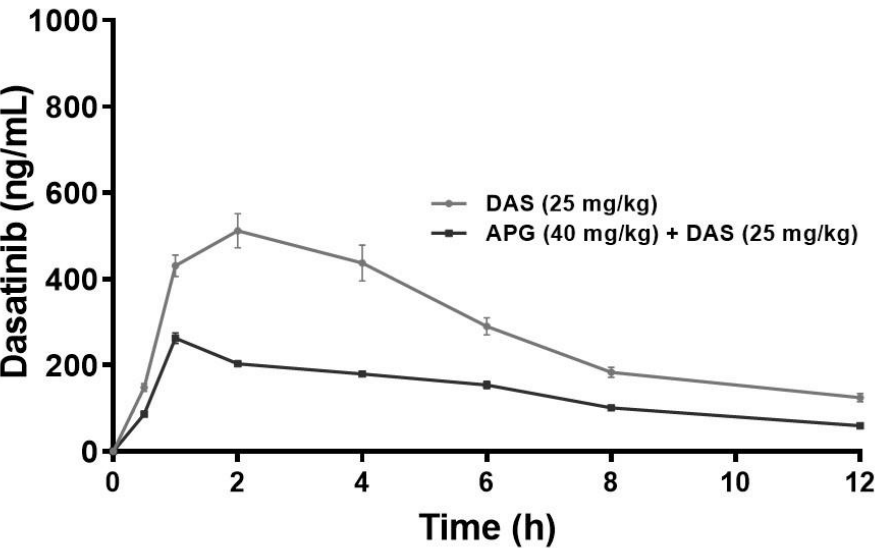
Figure 2. Plasma concentration–time curve of DAS and DAS along with APG (40 mg/kg p.o. for 7 days) following an oral administration in rats ( p < 0.05).